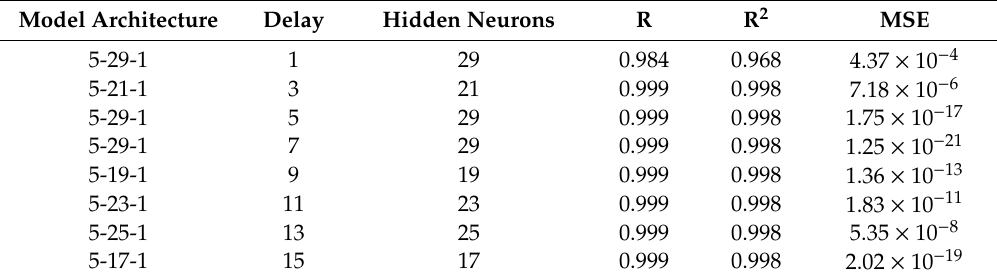
Table 4. Optimized hidden neuron obtained using data for Indonesia.